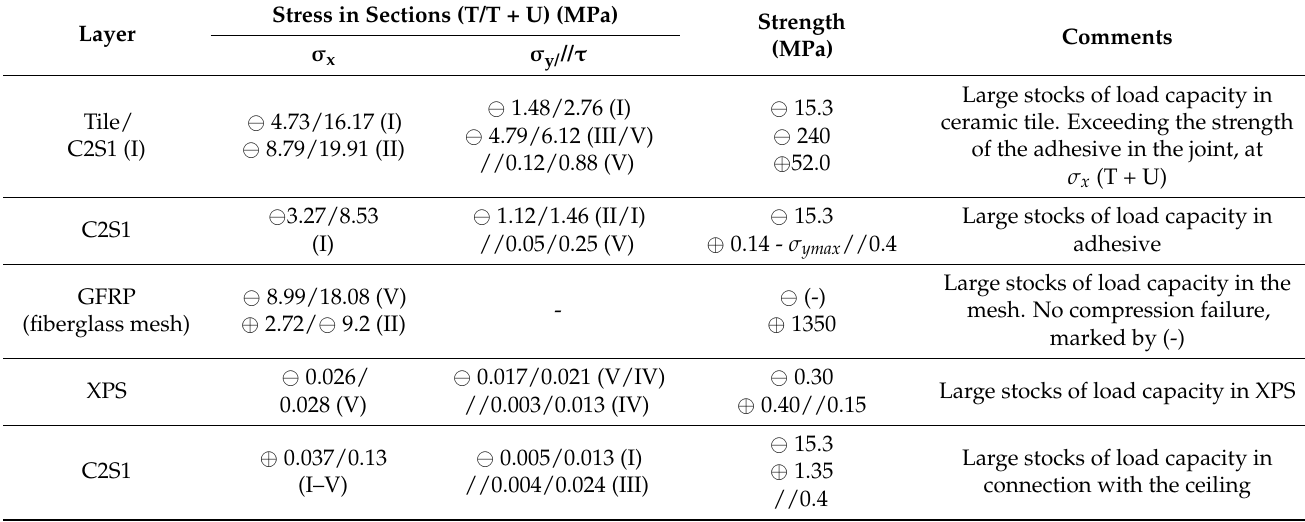
Table 3. The stresses in the particular materials of the lightweight